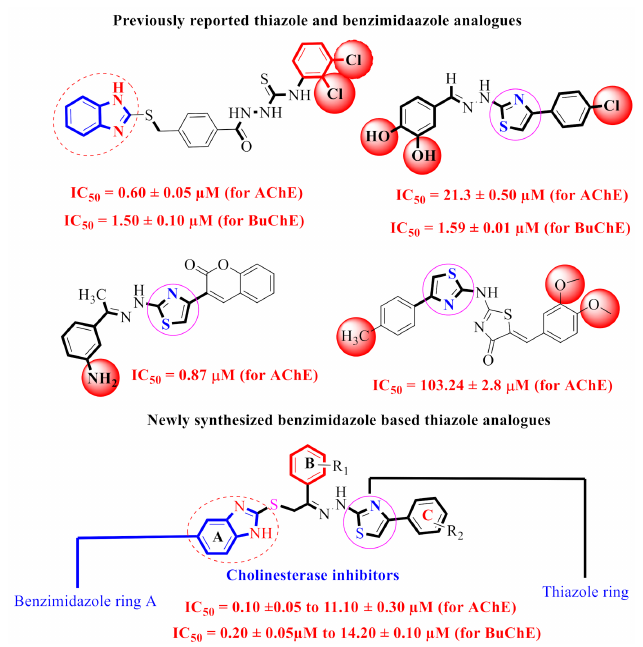
Figure 3. Rationale of the current